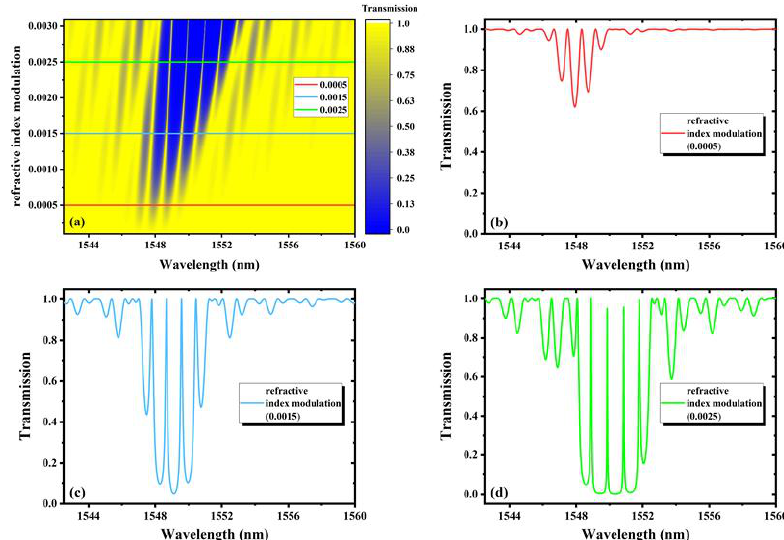
Figure 4. ( a )The transmission spectra with continuous variation of the refractive index modulation from 0.0001 to 0.003; the transmission spectra with the refractive index modulation of ( b ) 0.0005, ( c ) 0.0015 and ( d ) 0.0025.